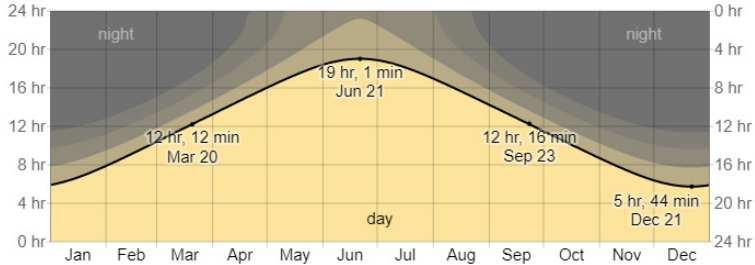
Figure 3. Average daily incident shortwave solar energy in Toronto, Canada [33].